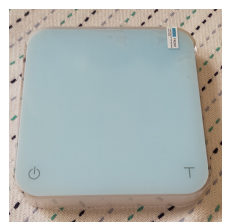
Figure 3. Acaia Pearl weight